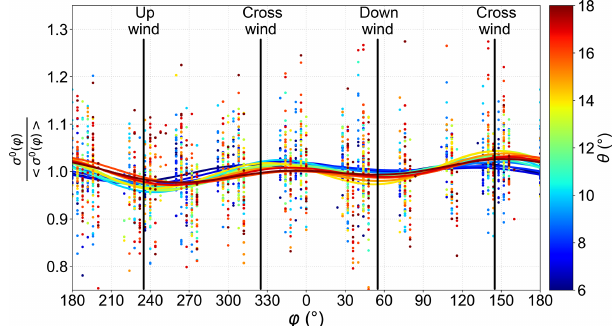
Figure 11. Same as Fig. 10c but using port-looking antenna data collected on 24 November at 11:22–13:03UTC.